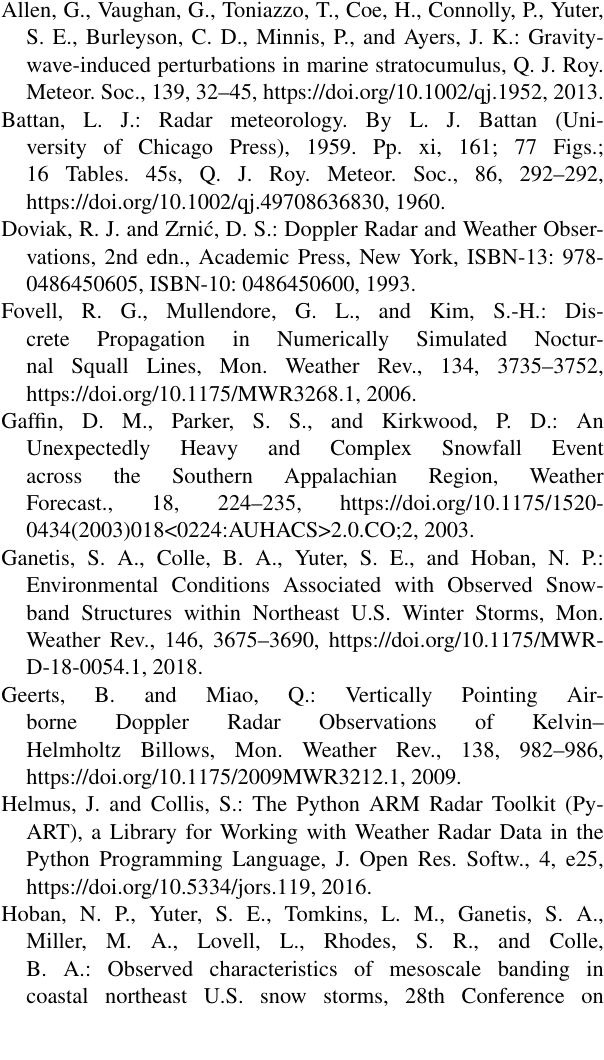
Animation-Figure-6: animated plot of a scanned RHI observed by KASPR radar at Stony Brook University on 1 February 2021 at 09:02:39UTC along the red lines in Fig. 5. RHIs extend from 179 ◦ (south) on the left to 359 ◦ (north) azimuth on the right. The panels starting at the top are reflectivity, binary wave de- tection, the difference between the KASPR radar’s dealiased ra-